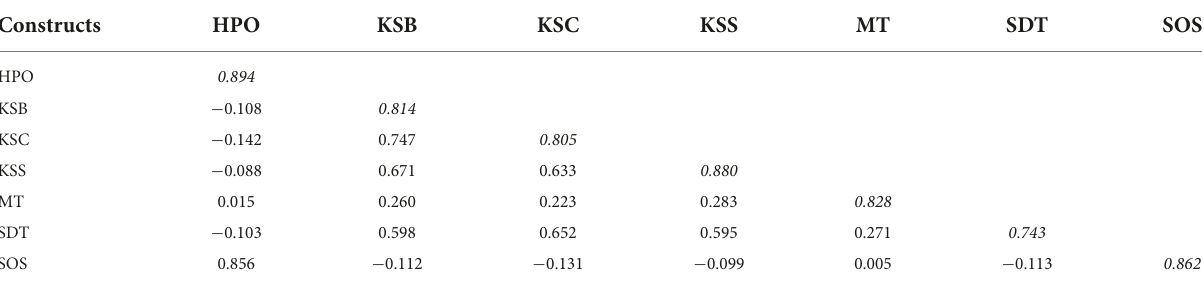
TABLE 3 Discriminate validity (Fornell and Larcker, criteria).